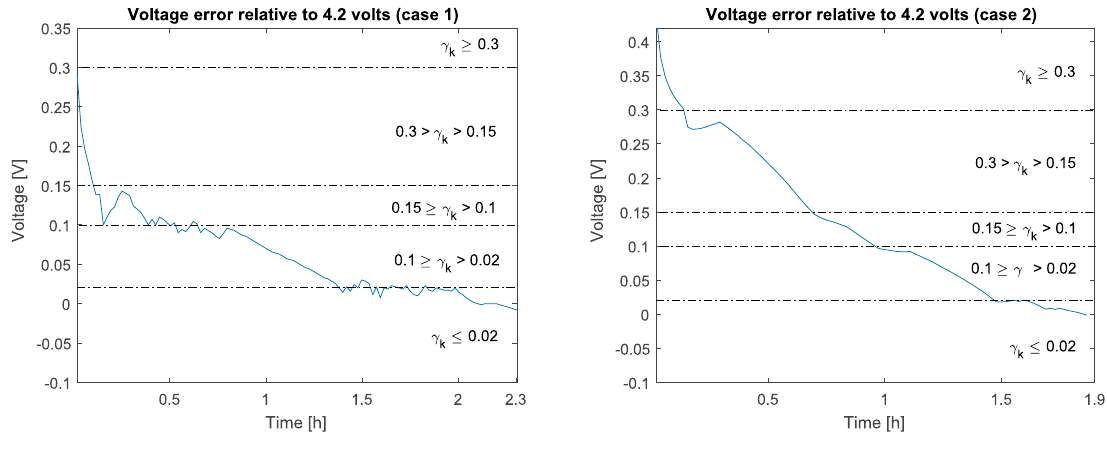
Figure 18. Error profile during charging.